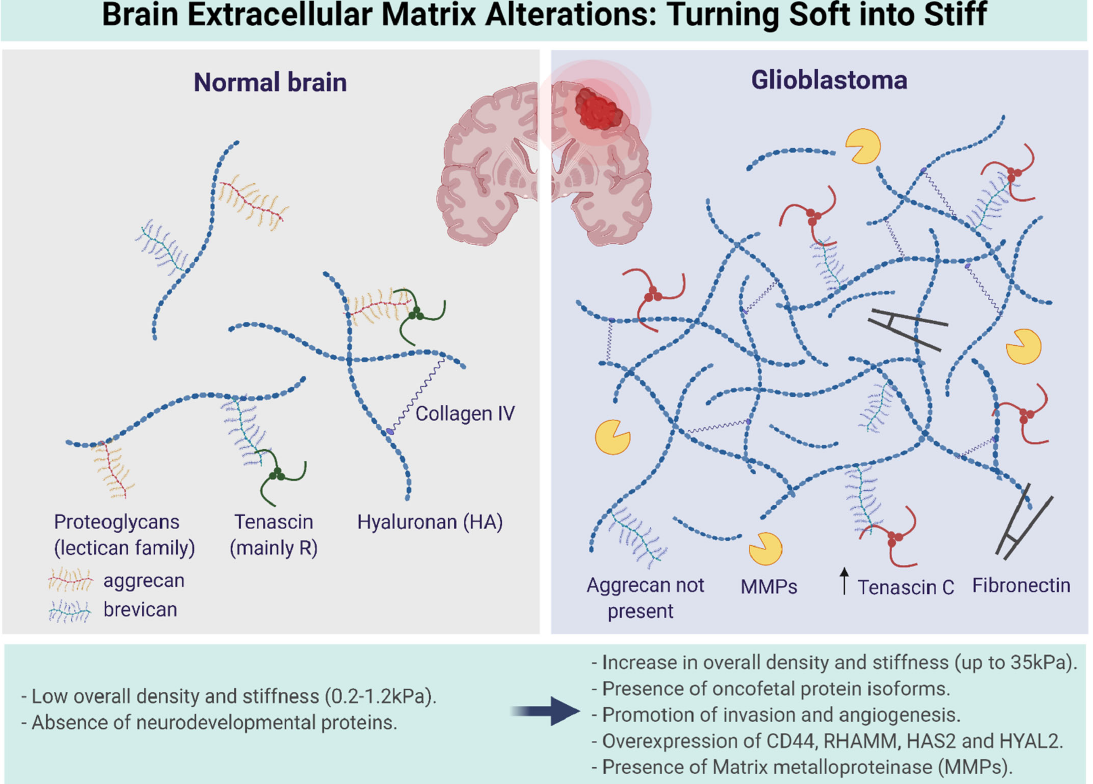
Figure 2. Overexpression of the brain extracellular matrix (ECM) components drastically alters its composition, mechanics, and physiochemical properties. Increased expression of hyaluronic acid, tenascin-C, fibronectin, and brevican, stiffens the ECM, which generates mechanical stress. Increased expression of HA-related genes such as CD44, RHAMM, and HAS2, intensifies HA overexpression. In addition, elevated presence of MMPs initiates matrix protein degradation, which weakens the ECM opposing the stiffening phenomena. Figure adapted from [12,25,38,39]. Many functions of the matrix also involve cell adhesion molecules (CAMs). CAMs are integral cell membrane proteins that mediate cell–cell and cell–matrix adhesion [40]. Among all types of CAMs, integrins and cadherins are the most important ones that bind directly to the ECM and cell cytoskeleton components, whereas integrins are the most important for mediating cell–matrix adhesion [41]. Thus, many ECM components have an effect on cell–cell and cell–ECM interactions, and as mentioned earlier, show GBM ‐ local ‐ ized alterations in expression that can extend to surrounding tissue [38]. GBM massively changes the ECM harmony within normal brain tissue, resulting in an abnormal ECM